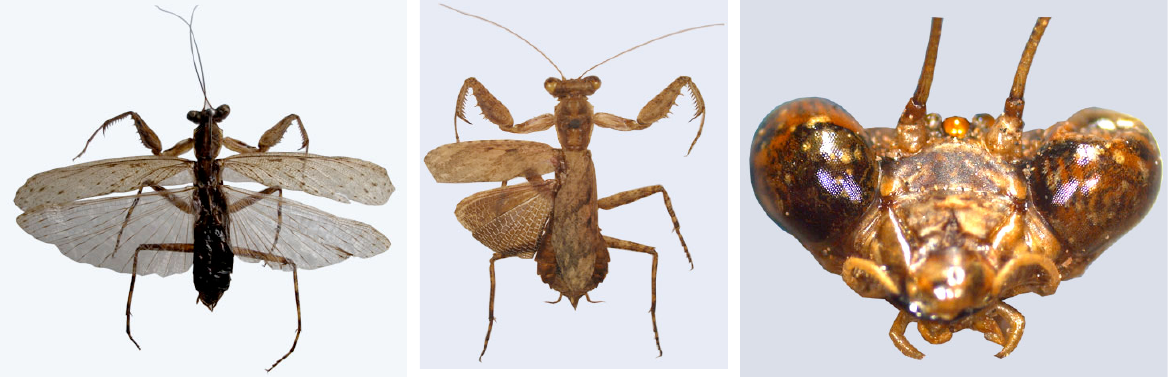
Image 12. Humbertiella similis Male